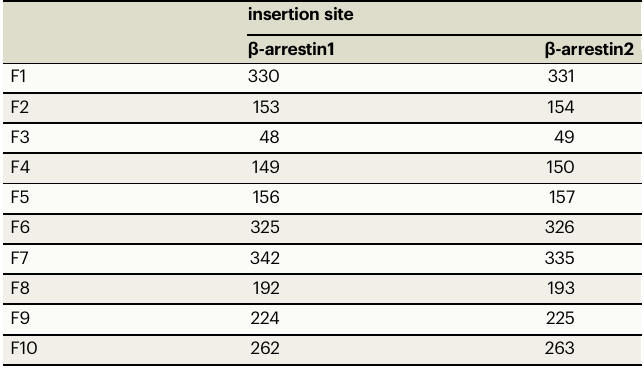
Table 1 | Insertion sites for FIAsH-binding insertion site